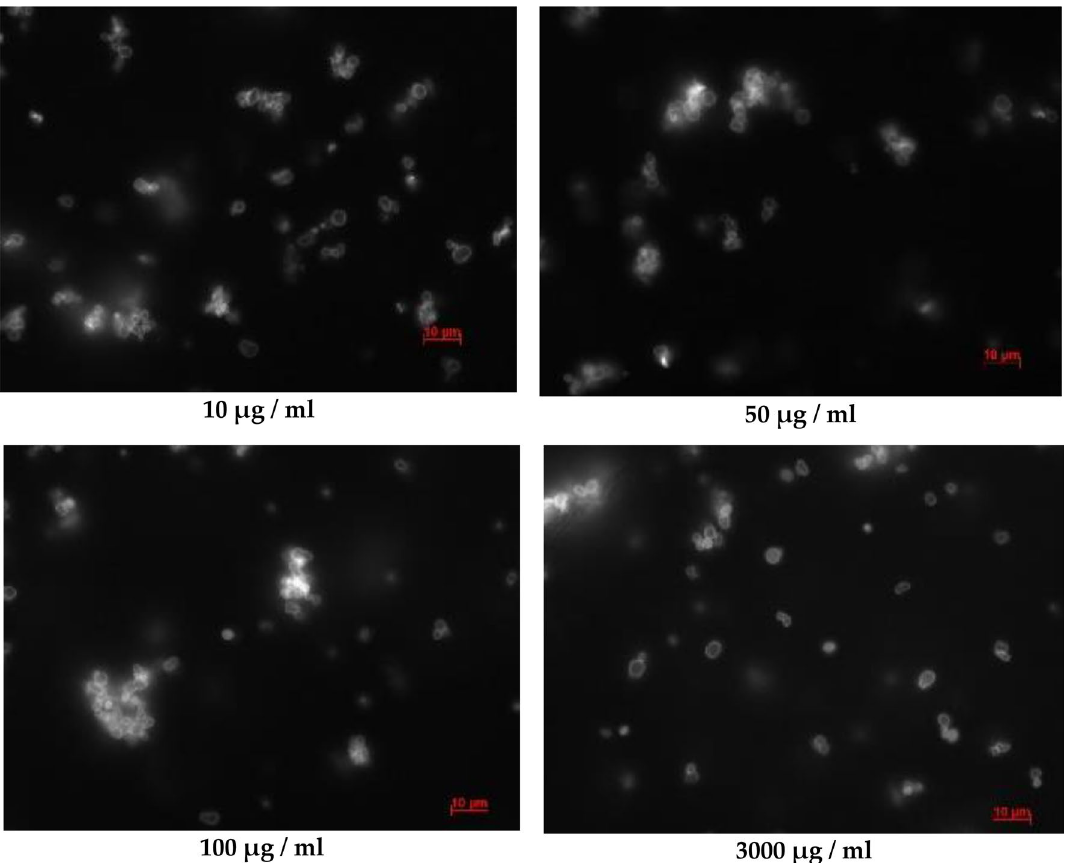
Figure 1. Image of polyelectrolyte microcapsules in SDS solution after 60 min of incubation(concentrations 10, 50, 100 and 3000 μg/ml).